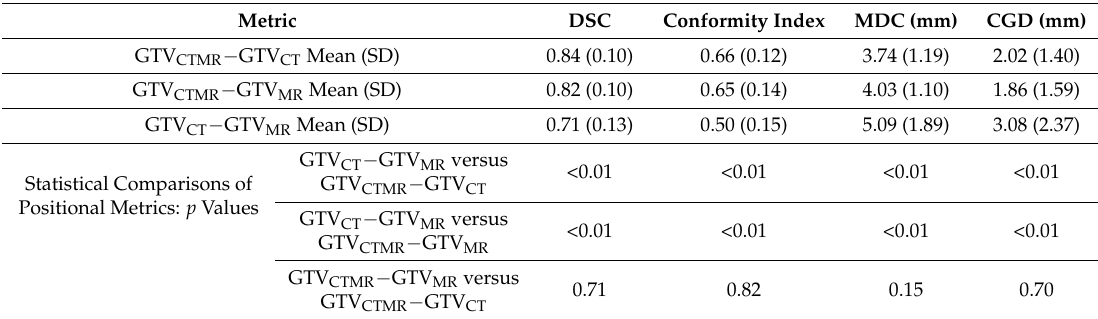
Table 3. Intermodality positional GTV